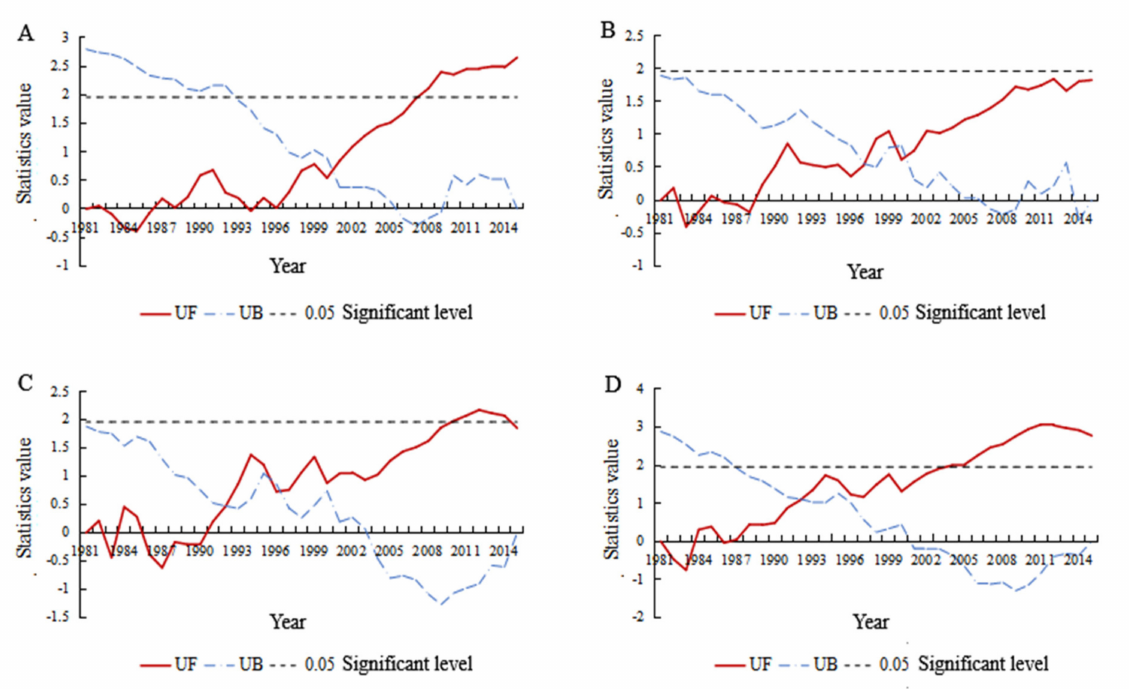
Figure 5. Mann–Kendall mutation analysis results of VCI time series for the southern ( A ), northern ( B ), northwestern ( C ) and Qinghai-Tibet ( D ) regions of